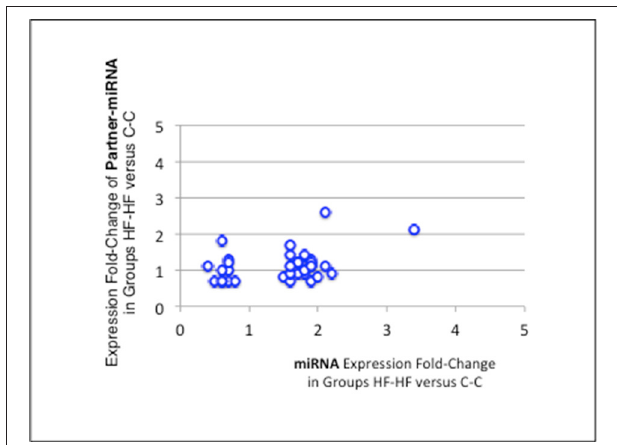
FIGURE 9 | miRNA and partner-miRNA differential expression in groups HF-HF vs. C-C. Thirty-four miRNAs specifically differentially expressed between groups C-C and HF-HF maturated in parallel with the second strand of their RNA duplex precursor (Partner-miRNA). Ratios of expressions (Fold-Change of Expression; FCE) of Partner-miRNAs were plotted against FCEs of miRNAs. Both FCEs displayed low correlation ( R 2 =